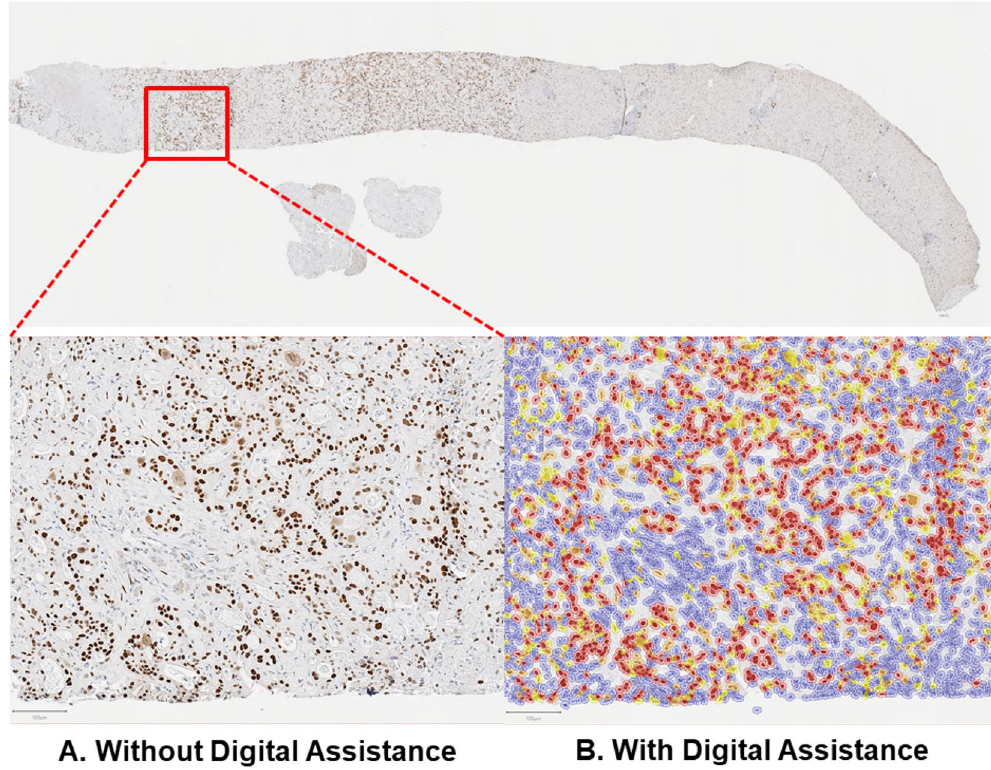
Figure 1. Pathologist workflow without and with digital assistance. In the assisted mode, the digital assistant provided GATA6 IHC expression for individual cells as a direct overlay. The pathologist had the option to toggle the digital assistant “off” ( A ) versus “on” ( B ) to better visualize tumor cells for assessment of GATA6 IHC expression. In both study phases (unassisted vs. assisted), pathologists recorded the final GATA6 IHC expression scores (0–4) for each